Question: Describe this figure in one sentence.
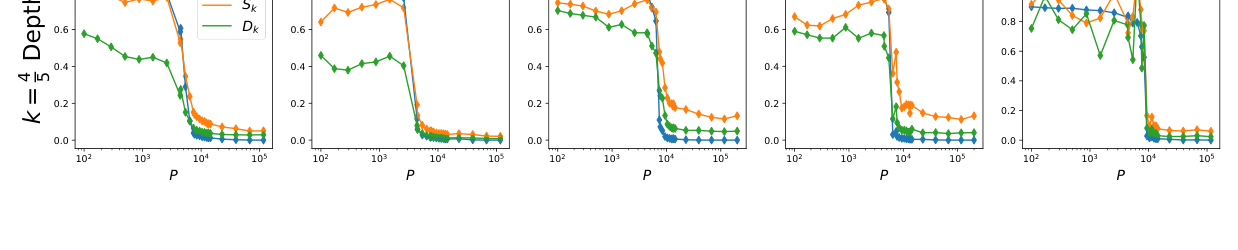
Answer: Test error (in blue), sensitivity to synonymic exchange (in orange), sensitivity to diffeomorphisms (in green) for increasing number of training points P of different common architectures (different columns). The sensitivities compute how much internal representations, at increasing relative depth k for increasing row, are sensitive to transformations applied at the input. Note that at 80% relative depth all the networks reach small sensitivities and test error for large enough P. We choose this relative depth for the results shown in Figure 1 (A,B). The sensitivities Sk and Dk refer to the case ℓ= 1 in Eq. 13 and Eq. 14.